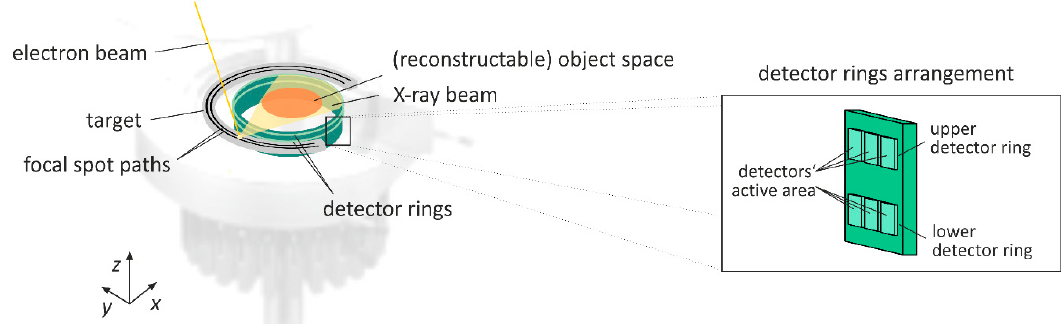
Figure 1. Functional principle of ultrafast electron beam X-ray computed tomography. Dim parts are components with minor functional meaning for computed tomography scans.